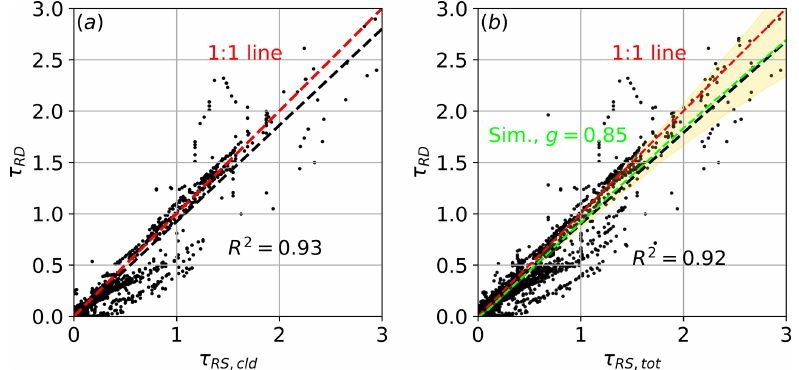
Figure 10. CAMP 2 Ex. (a) Above-aerosol-layer comparison: τ RS,cld vs. τ RD . (b) All data total-optical-depth comparison: τ RS,tot vs. τ RD . The dashed green line represents the expected τ RD given a value of τ RS,tot assuming g = 0 . 85.